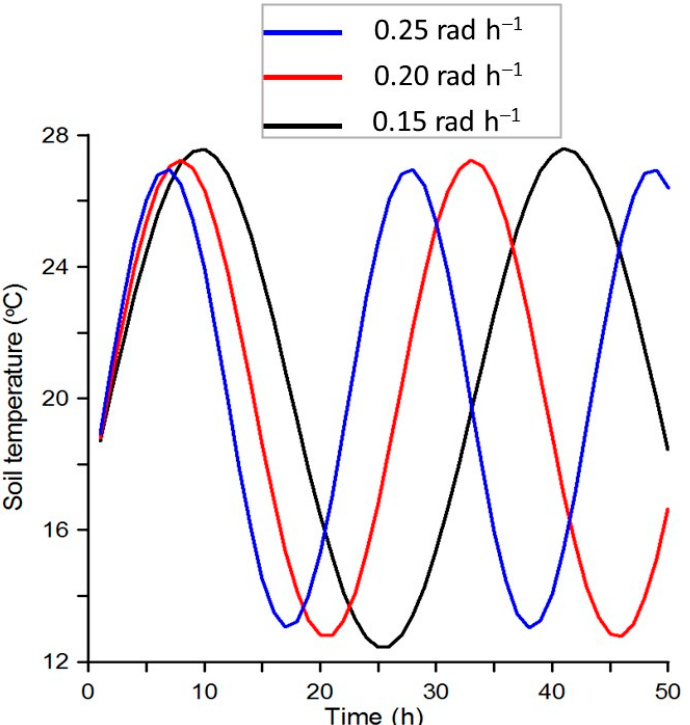
Figure 6. Dynamics of soil temperature variation in relation to temperature oscillation frequency at a depth of 5 cm.